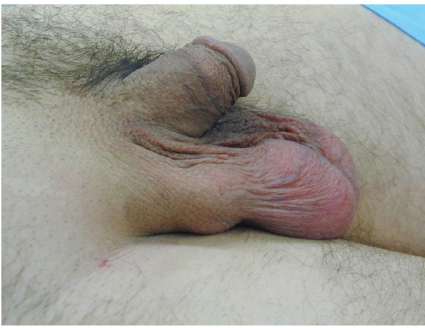
Figure 1: Physical appearance of right extra-testicular mass on 47 year old male.